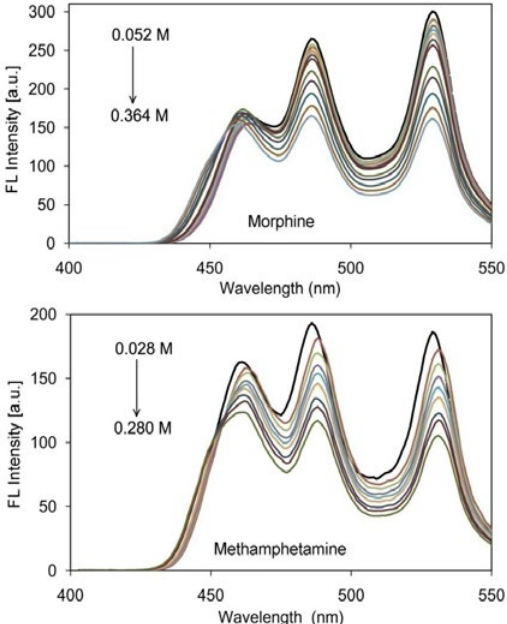
Fig. 7. The fluorescence spectra of L-cyst-CdS-QDs upon addition of the various concentrations of L-morphine and D-methamphetamine.